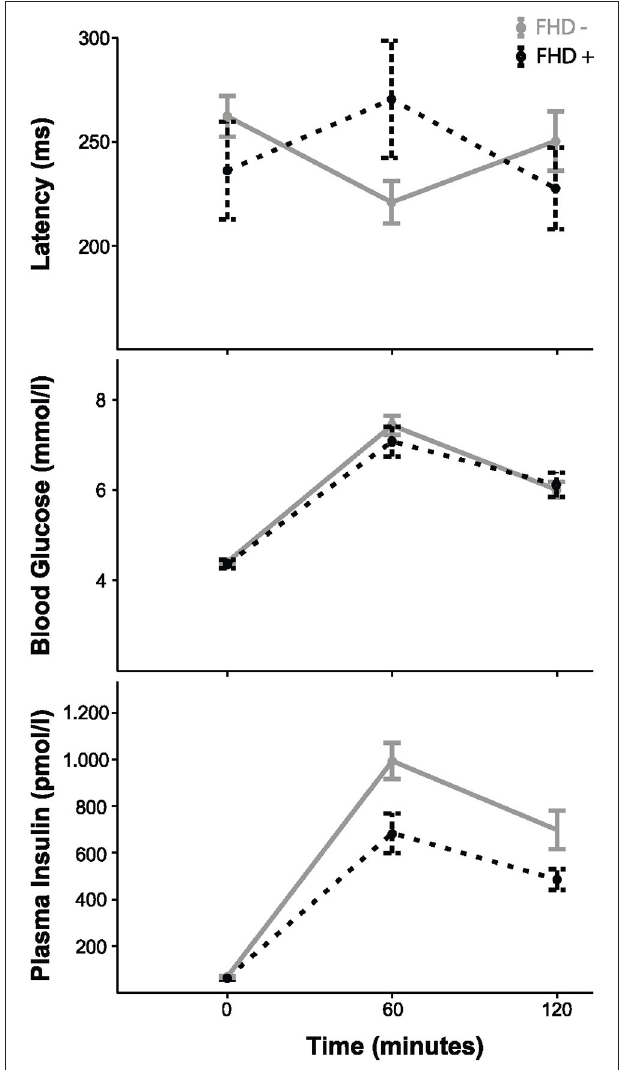
FIGURE 2 | Fetal auditory event-related responses, maternal blood glucose and insulin over the course of the oGTT in the FHD– ( n = 37) and FHD + ( n = 15) groups with mean ± 1